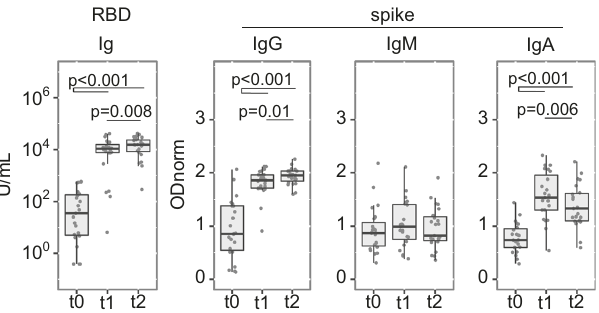
Fig. 5 Previous exposure to SARS-CoV-2 enhances vaccine-induced anti- SARS-CoV-2- spike reactivities. Shown are semi-quantitative measurements at t0, t1, and t2 for n = 23 participants identi fi ed as anti-N positive at t0, prior to BNT162b2 vaccination. Data points represent individual participants, boxes denote interquartile range, horizontal lines represent the median, and whiskers denote the minimum and maximum values below or above the median at 1.5 times the interquartile range. For anti-RBD Ig quanti fi cation, samples with a value > or = 2500 with the standard ECLIA assay were measured again after a 50x dilution. Quade test for group difference overtime points, p -values 5.383 × 10 − 10 for anti-RBD Ig, 8.013 × 10 − 10 for anti-spike IgG and 1.855× 10 − 09 for anti-spike IgA, and p = 0.24 for anti-spike IgM. Wilcoxon signed-rank test for pairwise comparison, two-sided, with p -value adjustment (Benjamini – Hochberg method), signi fi cant p -values indicated in each panel. For anti-RBD Ig, p = 4.3 × 10 − 05 (t0/t1 and t0/t2) and p = 0.0081 (t1/t2); for anti-spike IgG, p = 5.7 × 10 − 05 (t0/t1 and t0/t2) and p = 0.014 (t1/t2); for anti-spike IgA p = 7.3 × 10 − 05 (t0/t1 and t0/t2) and p = 0.0059 (t1/t2). Source data are provided as a Source Data fi